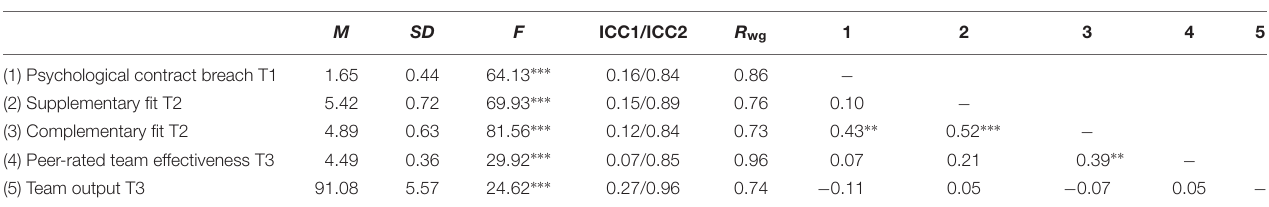
TABLE 1 | Means, standard deviations, and correlations at the team